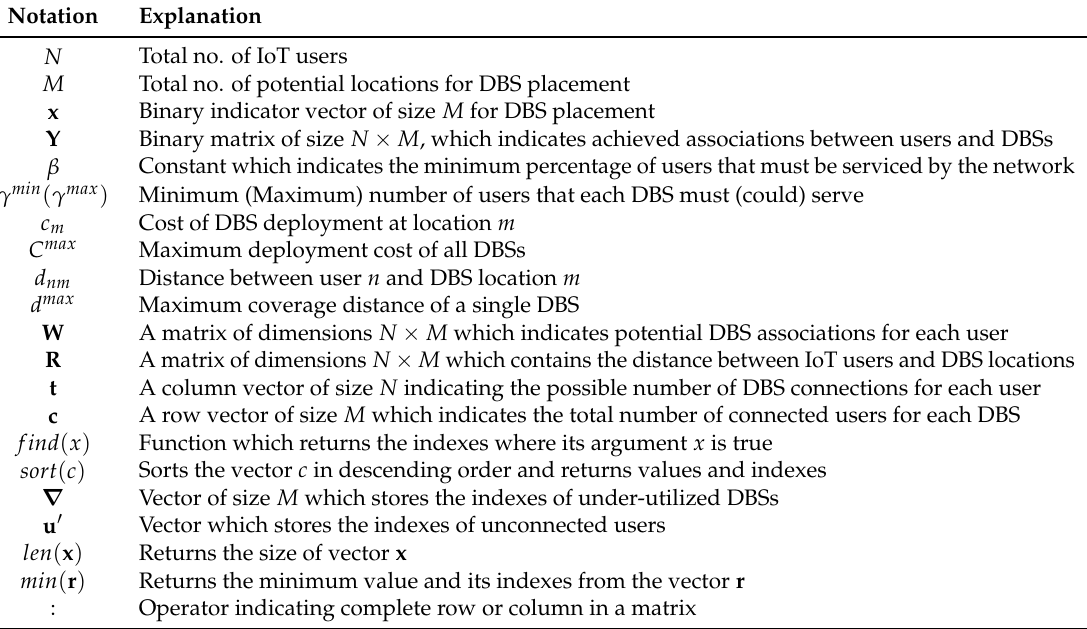
Table 1. List of notations and variables of this